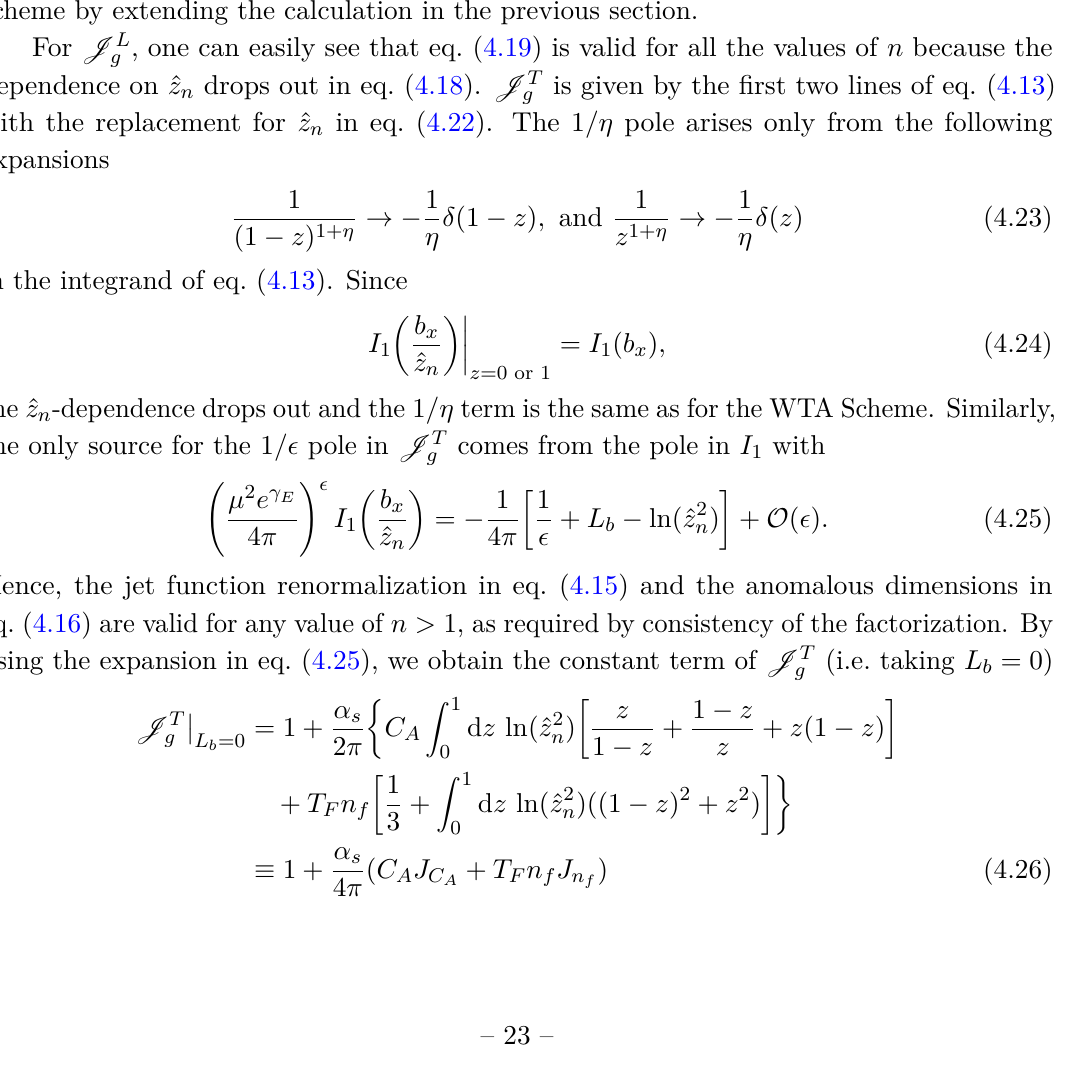
Figure 4. Finite part (i.e. L b = 0 ) of the contributions from gluons ( J C gluon and to the quark ( J C The results for the WTA scheme (black dashed lines) are approached for n → ∞ . J C J C are defined in eq. (4.26) and eq. (4.29), A